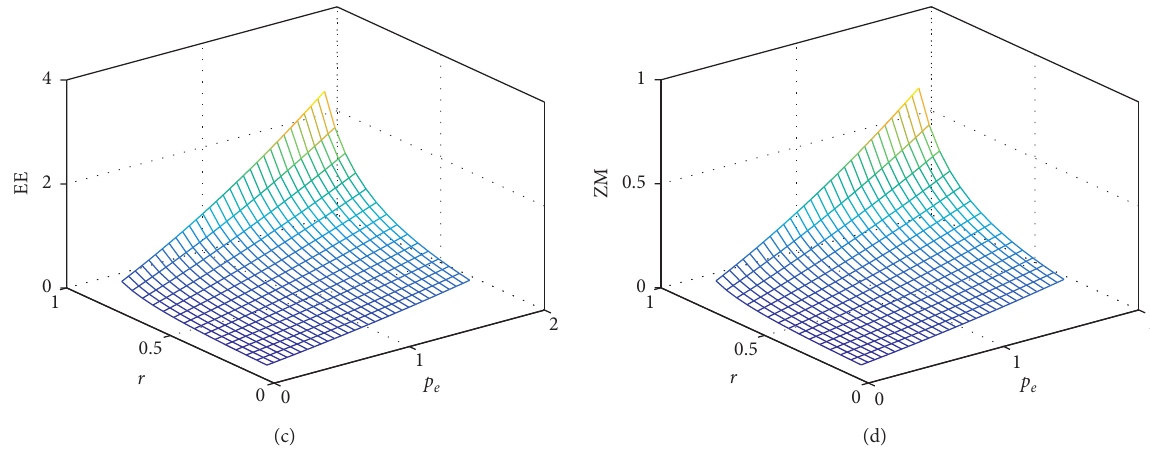
Figure 6: Sensitivity analysis of carbon trading price and cost subsidy